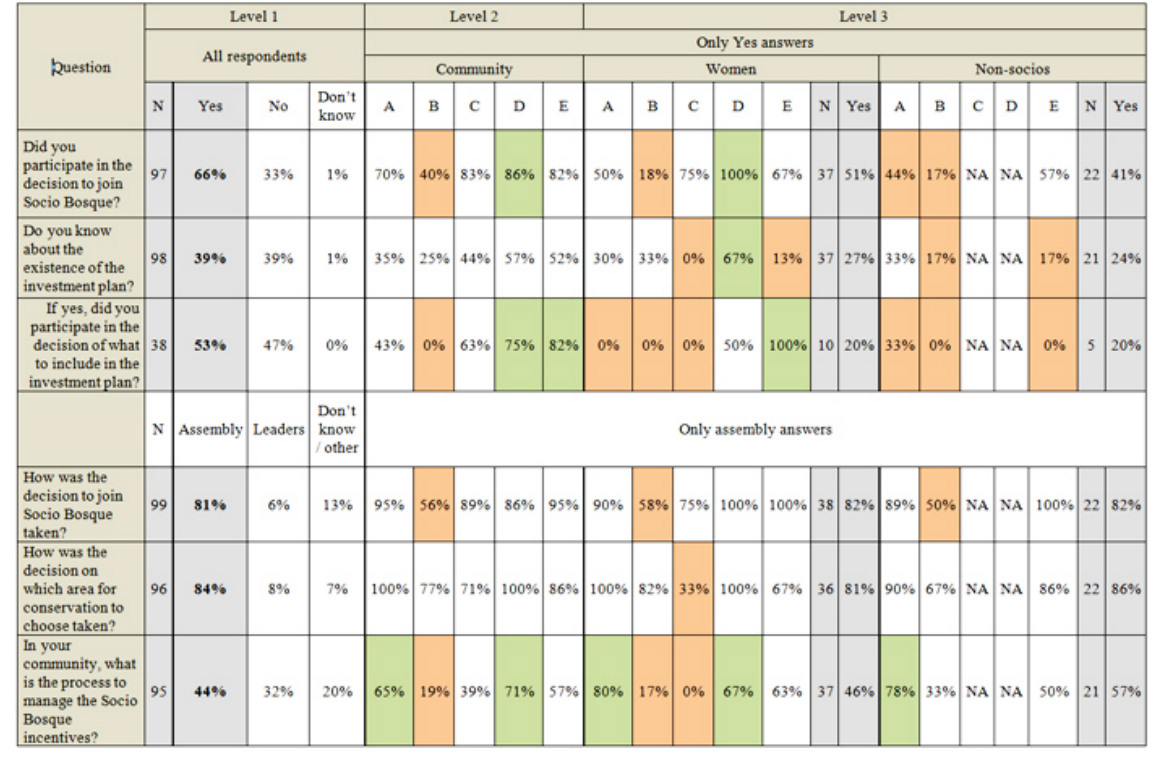
Fig. 1 . Interview questions and answers related to full and effective participation for all respondents (Level 1), by individual communities (Level 2), and for women and non-socios within each community (Level 3). The percentages are relative to the number of respondents in that group (i.e., total respondents in each community for Level 2, or total women or non-socios in each community for Level 3). Means across all communities for the total number of women and non-socios are shown in gray columns. The percentages for each group are highlighted in green when ‡ 20% higher than the global mean (Level 1), or yellow when ‡ 20% lower than the global mean. Bold font indicates the aggregated “Yes” answers on which the disaggregated answers for each community are based. NA = not